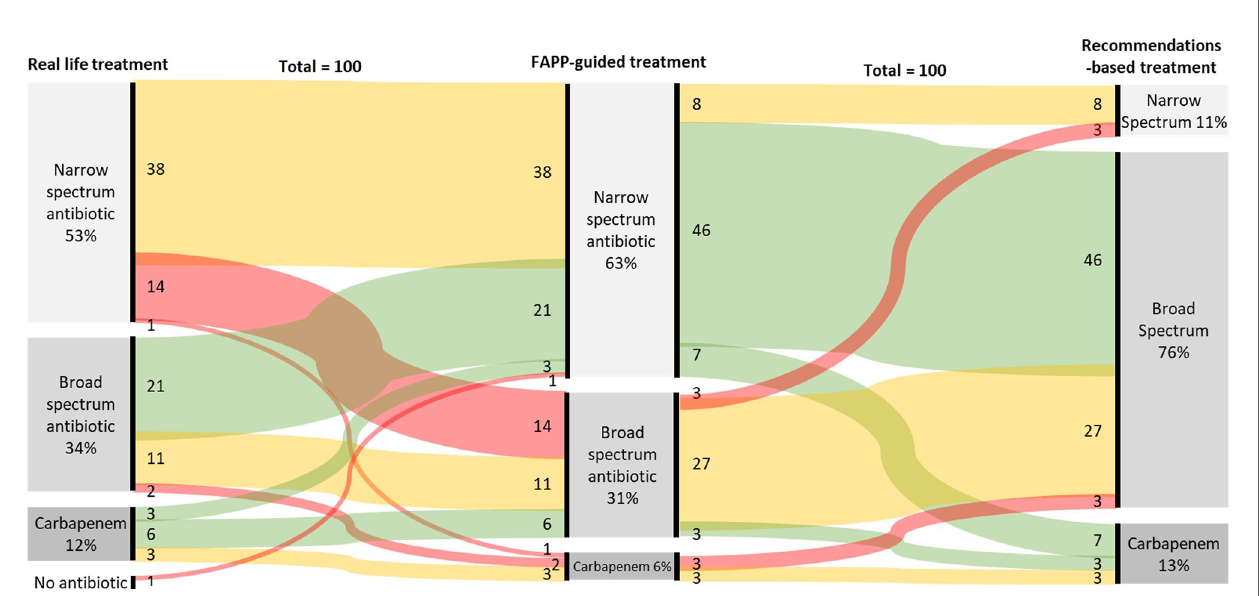
FIGURE 2 | Sankey chart of real-life empirical treatments implemented without FAPP (left column), antimicrobial therapies simulated with the results of FAPP (Middle column), and antimicrobial therapies simulated by following the actual recommendations (right column). Red lines stand for antibiotic escalation, green for de- escalation, and yellow for no